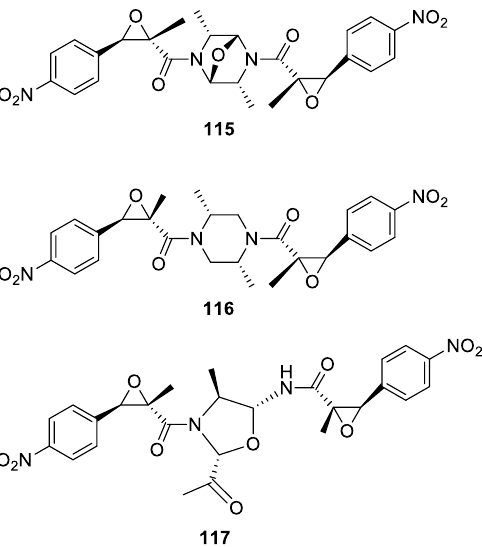
Figure 21. Natural products with two nitrophenyl trans -epoxyamides, chrysamides A − C ( 115 – 117 ) isolated from the deep-sea fungus Penicillium chrysogenum .